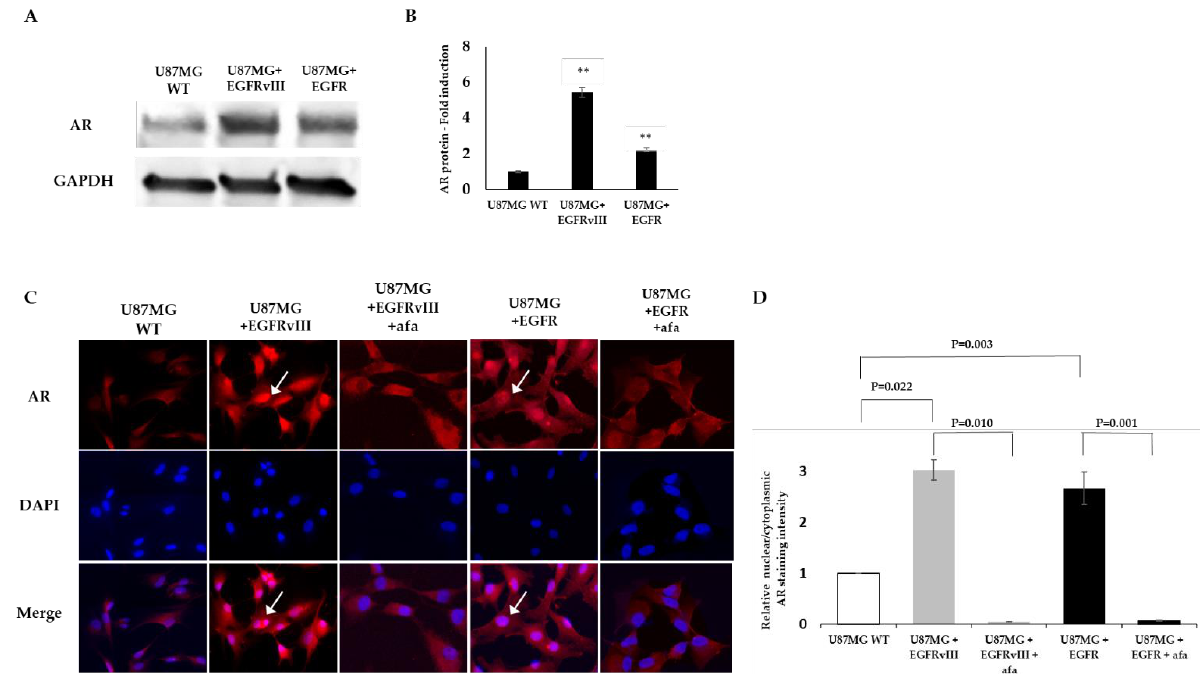
Figure 2. EGFR promotes AR overexpression in the U87MG glioblastoma cell line model. ( A ) Western blot analysis using anti-AR (D6F11) in U87MG WT, U87MG EGFR, and U87MG EGFRvIII cells (upper gel). The anti-GAPDH housekeeping protein was used as a loading control (lower gel). ( B ) Androgen receptor protein level in U87MG WT, U87MG EGFR, and U87MG EGFRvIII cells ( x -axis) was analyzed by PathScan ® Total Androgen Receptor Sandwich ELISA Kit. AR fold induction compared to U87MG WT is represented ( Y -axis). The experiments were repeated three times. The results of the relative fold induction are presented as the mean ± SD. ** p < 0.01 versus the U87MG control group. ( C ) Immunofluorescence staining for anti-AR (D6F11) (red) in vehicle and afatinib-treated U87MG WT, EGFR, or EGFRvIII cells. Cell nuclei were stained with DAPI (blue). White arrows indicate AR nuclear staining. ( D ) Relative AR nuclear localization was determined by quantification of the relative fluorescent intensity ratio between nuclear and cytosolic compartments using ImageJ software. The results are expressed as mean ± SD following normalization to U87MG WT; p -values between the groups are indicated.